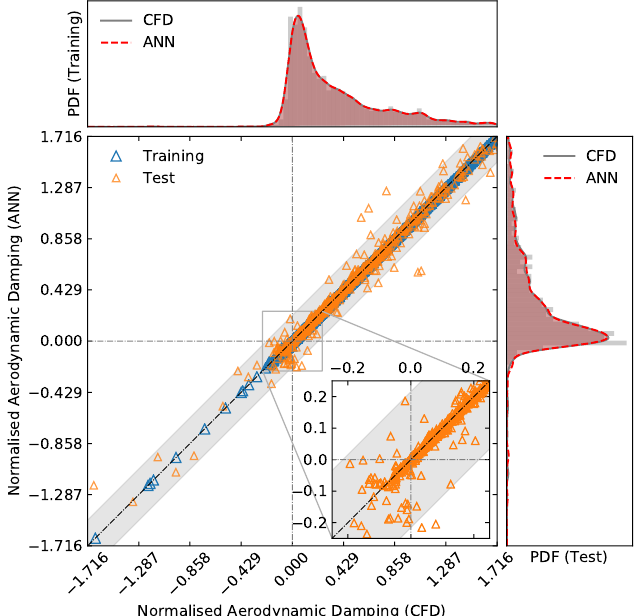
Figure 6. PDF and scatter plot of CFD data points and ANN “reproductions”.